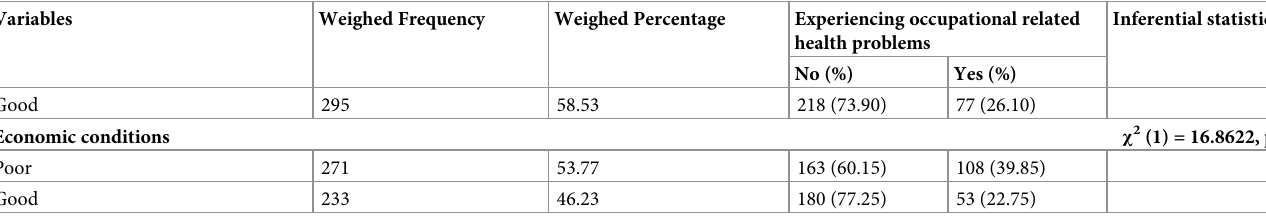
Table 3 is a nested multivariate logistic regression showing the three models; key predictors + compositional model, contextual model and working conditions model for predicting experiencing occupational related health problems by goldminers in Ghana. In model 1 (key predictors + compositional factors), miners in LSM production and LSM